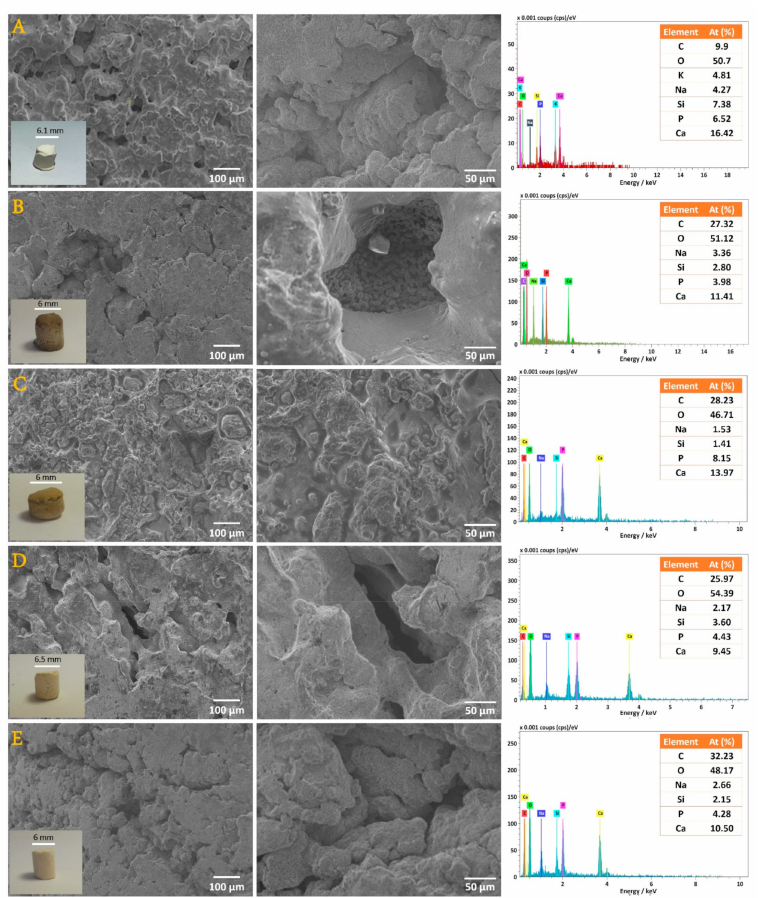
Figure 3. SEM micrographs and the corresponding EDS patterns of consolidated